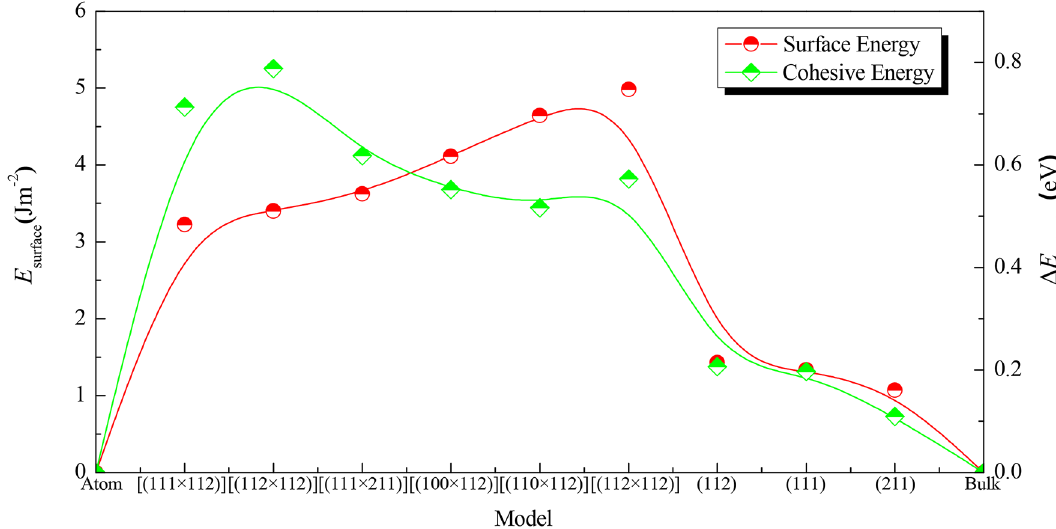
Figure 2. Schematic diagram of the surface energy and cohesive energy for MnO 2 bulk surface and